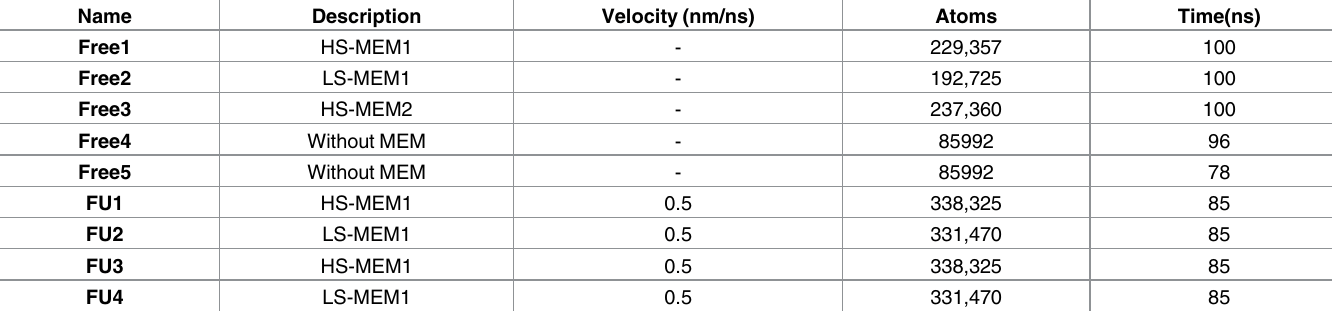
Table 1. Summaryof MD simulations